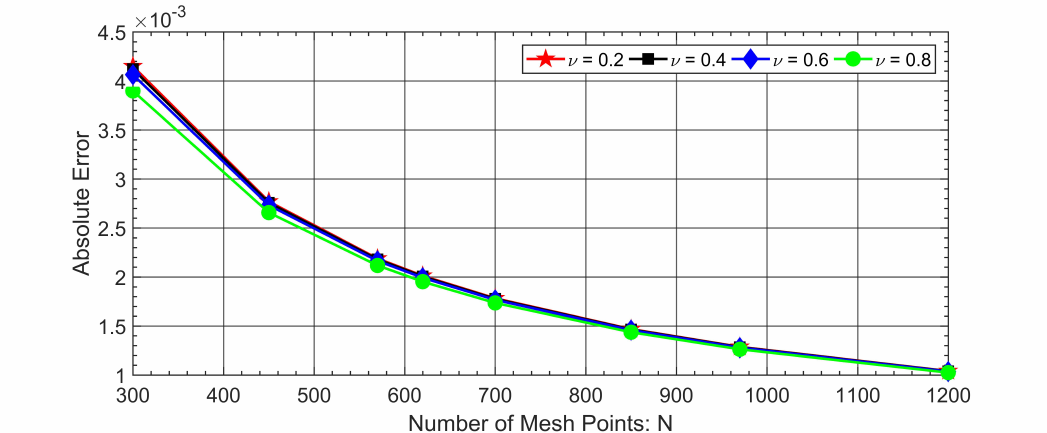
Figure 2. Absolute errors vs. number of mesh points N for the approximation of continuous uniform mesh for a temporal variable using the Caputo-Fabrizio operator on a given function f ( t ) = t 2 with varying fractional order ν .